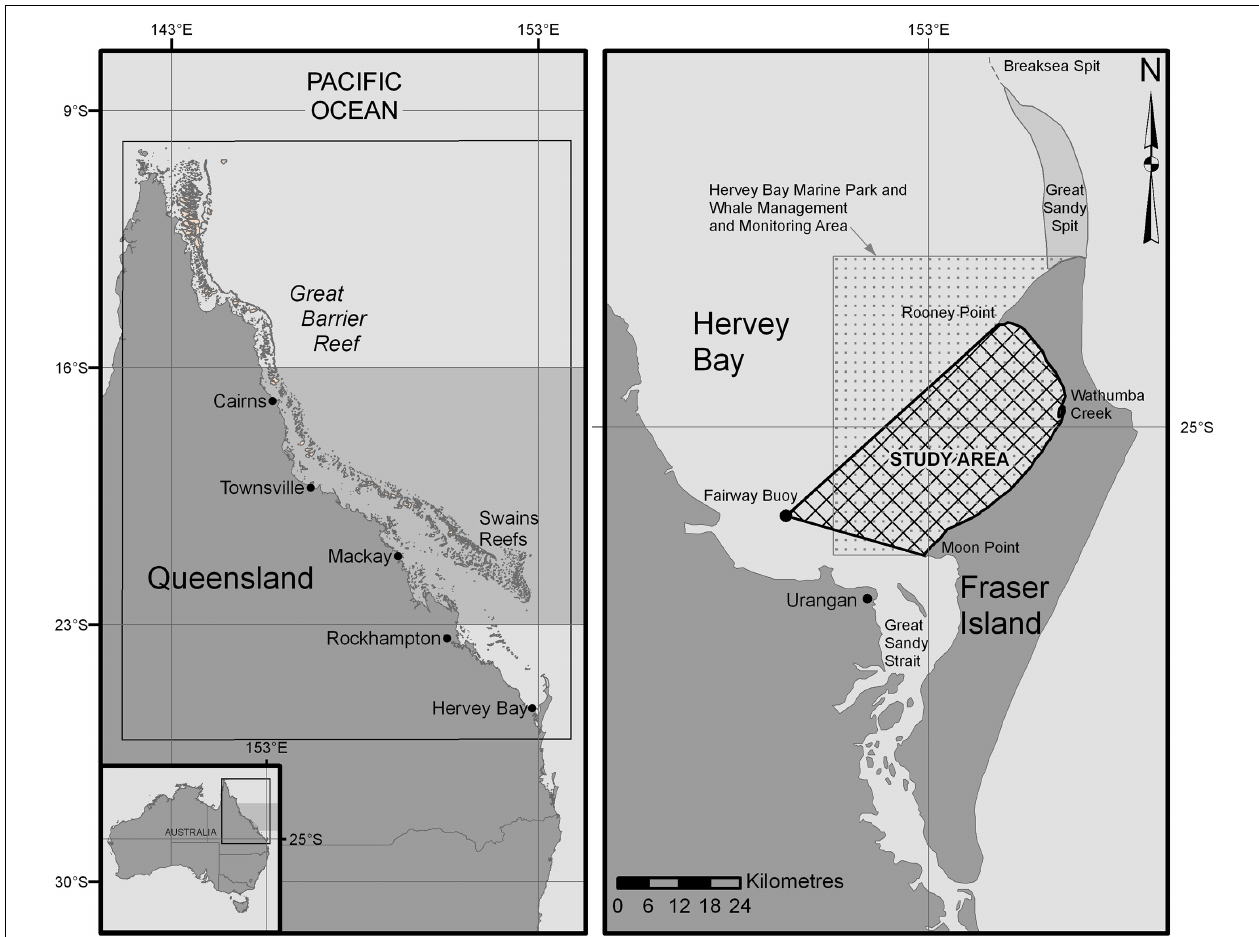
FIGURE 1 | The location of Hervey Bay on the eastern coast of Australia and its geographic relationship to the Great Barrier Reef and presumed breeding grounds (16 ◦ S–23 ◦ S; shaded area) of humpback whales is shown on the left-side map. The study area and the Hervey Bay Marine Park boundaries are shown on the eastern side of Hervey Bay. A primary feeding area for eastern Australian humpback whales is around the Balleny Islands, approximately 5,000 km south of Hervey Bay (Franklin et al., 2012; Constantine et al., 2014); although, the feeding range of Southern Ocean humpback whales spreads widely across Antarctica from the Balleny islands, east (Dalla Rosa et al., 2012) and west (Franklin et al., 2017).